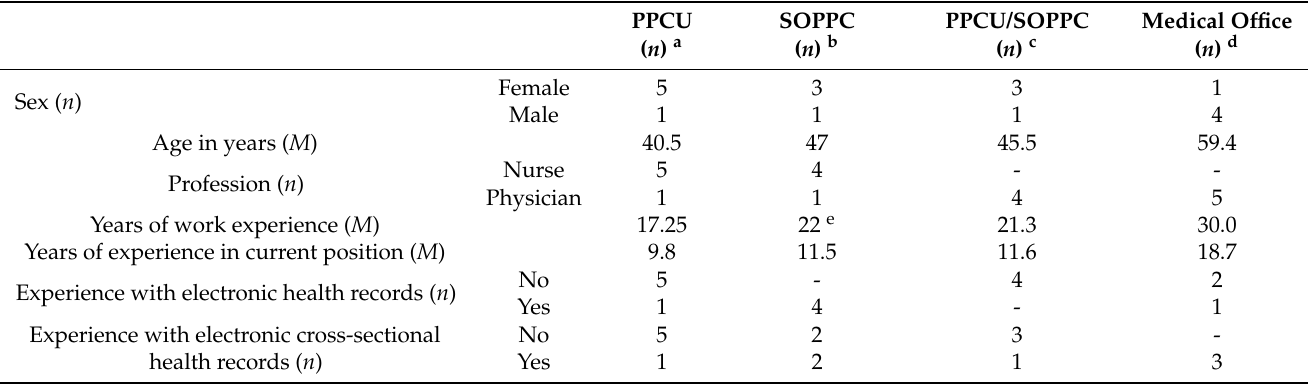
a n = 6. b n = 5; (One nurse’s characteristics are missing due to the nonreturn of the questionnaire). c n = 4. d n = 5 (Two physicians’ characteristics are missing due to the nonreturn of the questionnaires). e This question was answered by three participants from the SOPPC teams (One nurse’s characteristics are